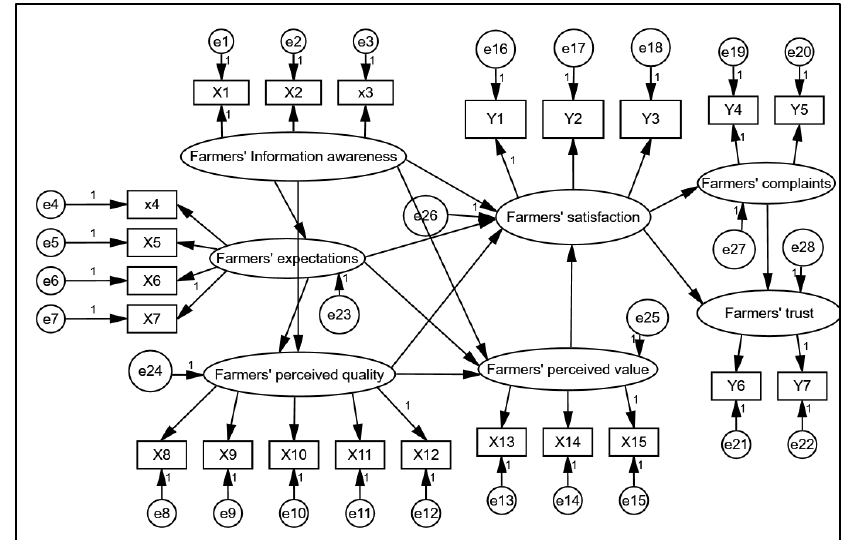
Figure 4. Preliminary structural equation model.